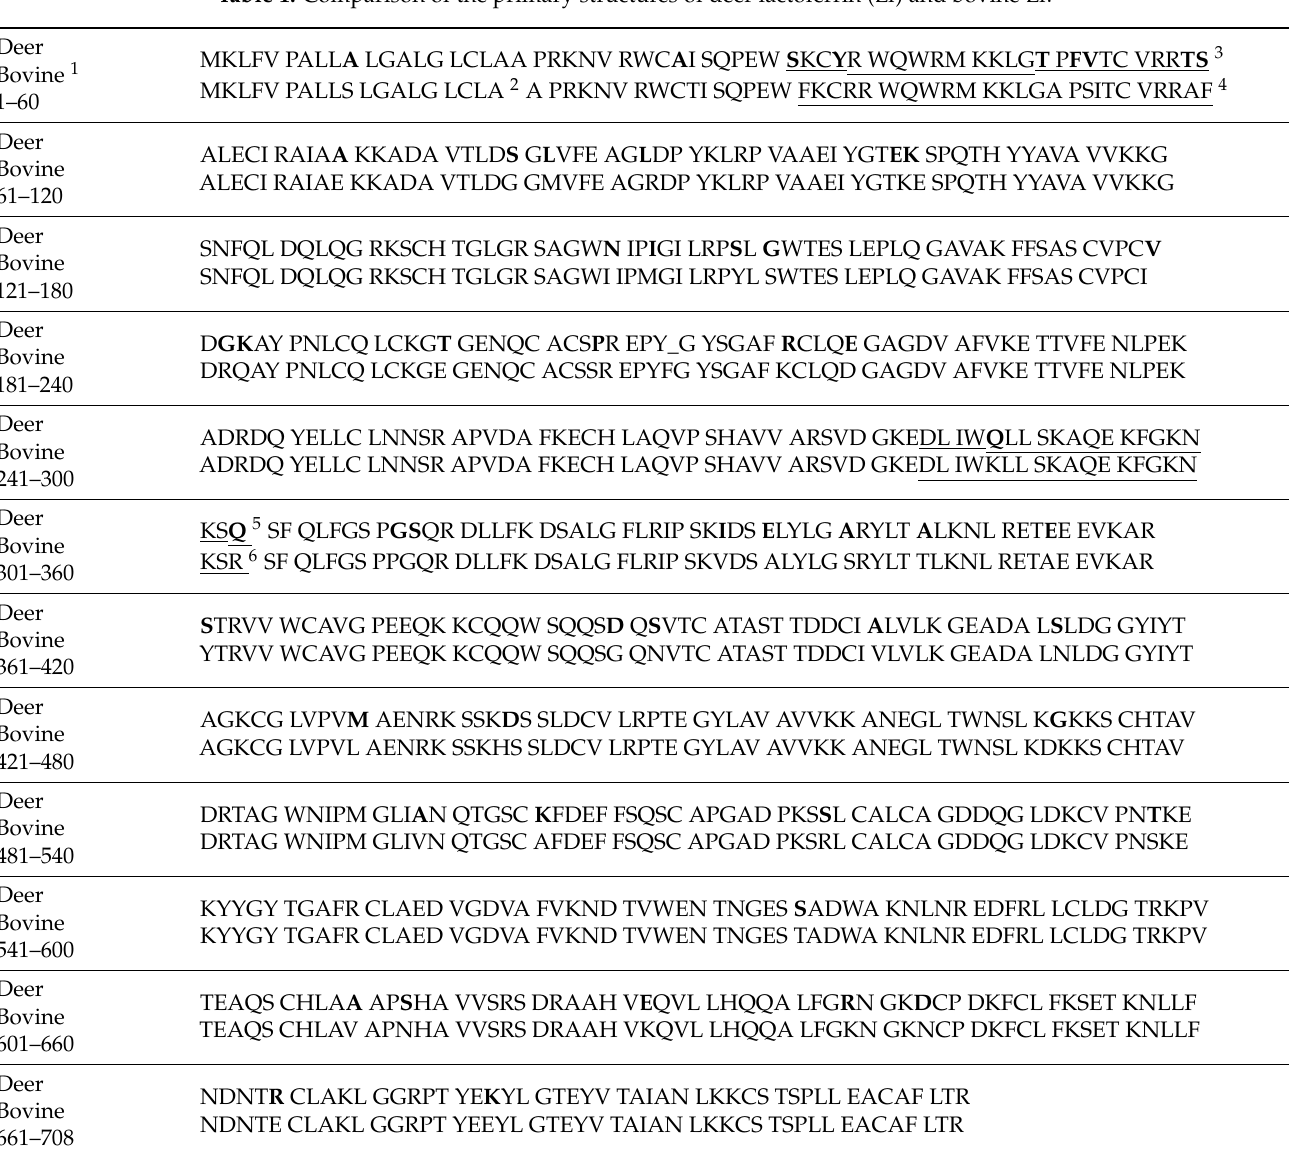
Table 1. Comparison of the primary structures of deer lactoferrin (Lf) and bovine